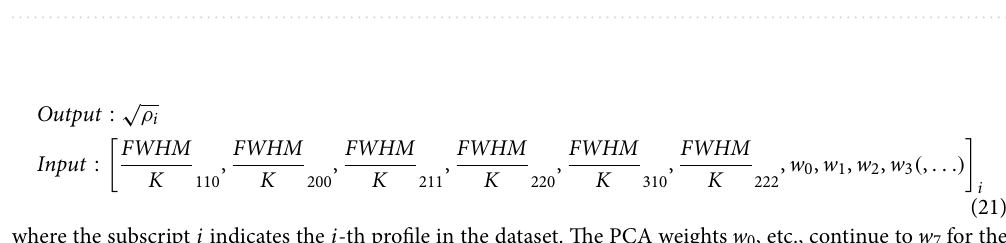
Table 5. Kernel function forms which are tested to determine the best performing alternative.